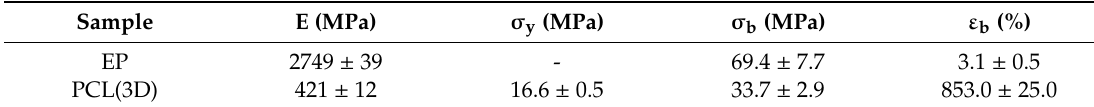
Figure 3. Representative stress–strain curves obtained from quasi-static tensile tests at break on the constituents. ( a ) EP, ( b ) PCL(3D) samples. Table 1. Results of quasi-static tensile tests on EP and PCL(3D) samples.